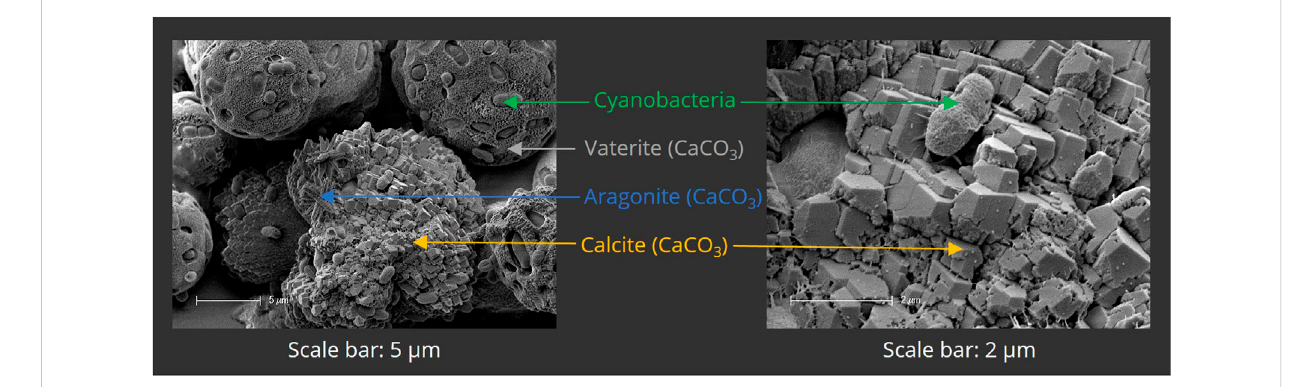
FIGURE 5 Scanning electron micrographs of mineralized PCC 7002 after 7 days of mineralization. Bacterial cells are surrounded by mineralized calcium carbonate (CaCO 3 ), present in the different polymorphs vaterite, aragonite and calcite.